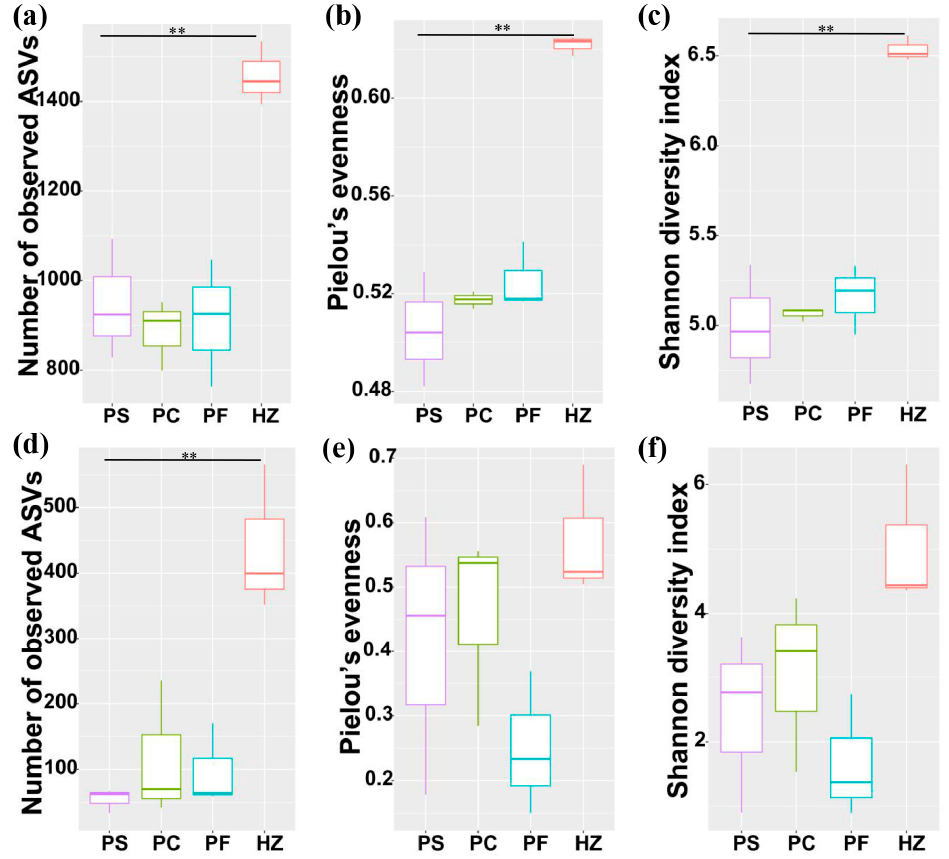
Figure 4. Alpha diversity estimates of the bacterial ( a – c ) and archaeal ( d – f ) communities. ( a , d ) ASV richness estimates (number of observed ASVs). ( b , e ) Pielou’s evenness estimates. ( c , f ) Shannon diversity indices. Significant differences ( p < 0.01) across samples are indicated with “**”.